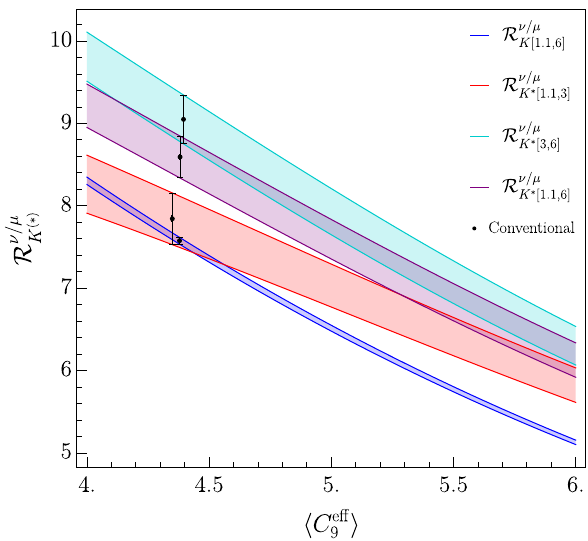
(ν/μ) (ν/μ) Fig. 5 The ratios R and R are plotted as a function of the K K ∗ in a fixed q 2 bin. The black points correspond to average value of C eff 9 the predictions obtained using the C eff input from Ref. [63]. Note that 9 (ν/μ) is practically constant in the low- q 2 region and, for this the ratio R K reason, is only plotted in the [ 1 . 1 , 6 ] GeV 2 bin, see Fig.